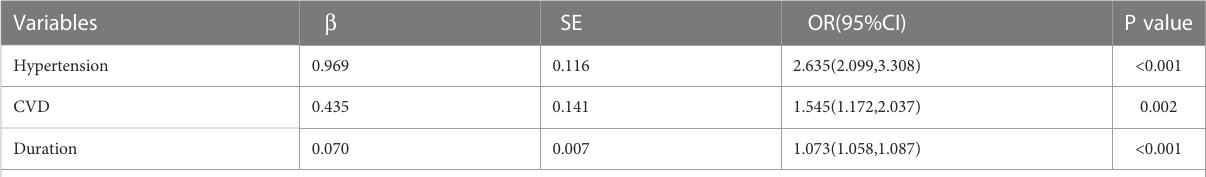
TABLE 3 Results of multivariate logistic regression